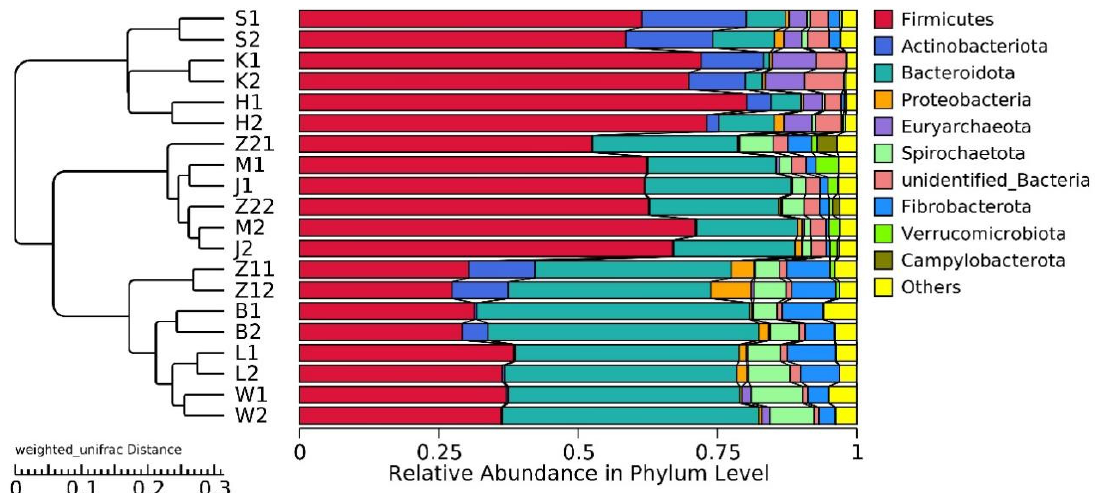
Figure 2. Histogram of gastrointestinal relative abundance in different groups at phylum level, and UPGMA clustering tree based on weighted UniFrac distance.